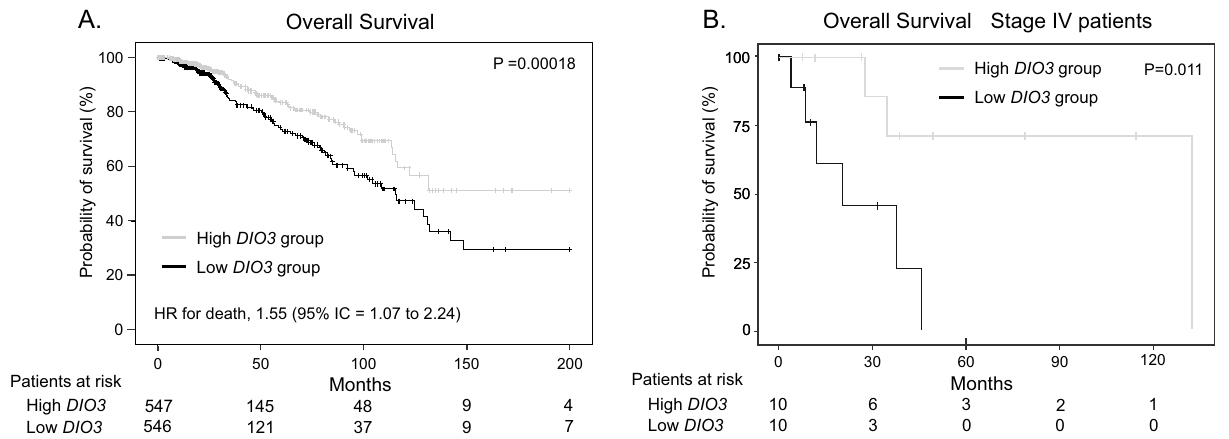
Figure 4. Kaplan–Meier estimates of overall survival in patients of the TCGA-BRCA cohort according to DIO3 mRNA expression. Patients were grouped according to the median of DIO3 expression in the population as presenting high DIO3 expression (gray lines) or low DIO3 expression (black lines). Plot A shows the overall survival in the entire cohort. Plot B refers only to patients with stage IV disease. HR = hazard ratio; CI = confidence